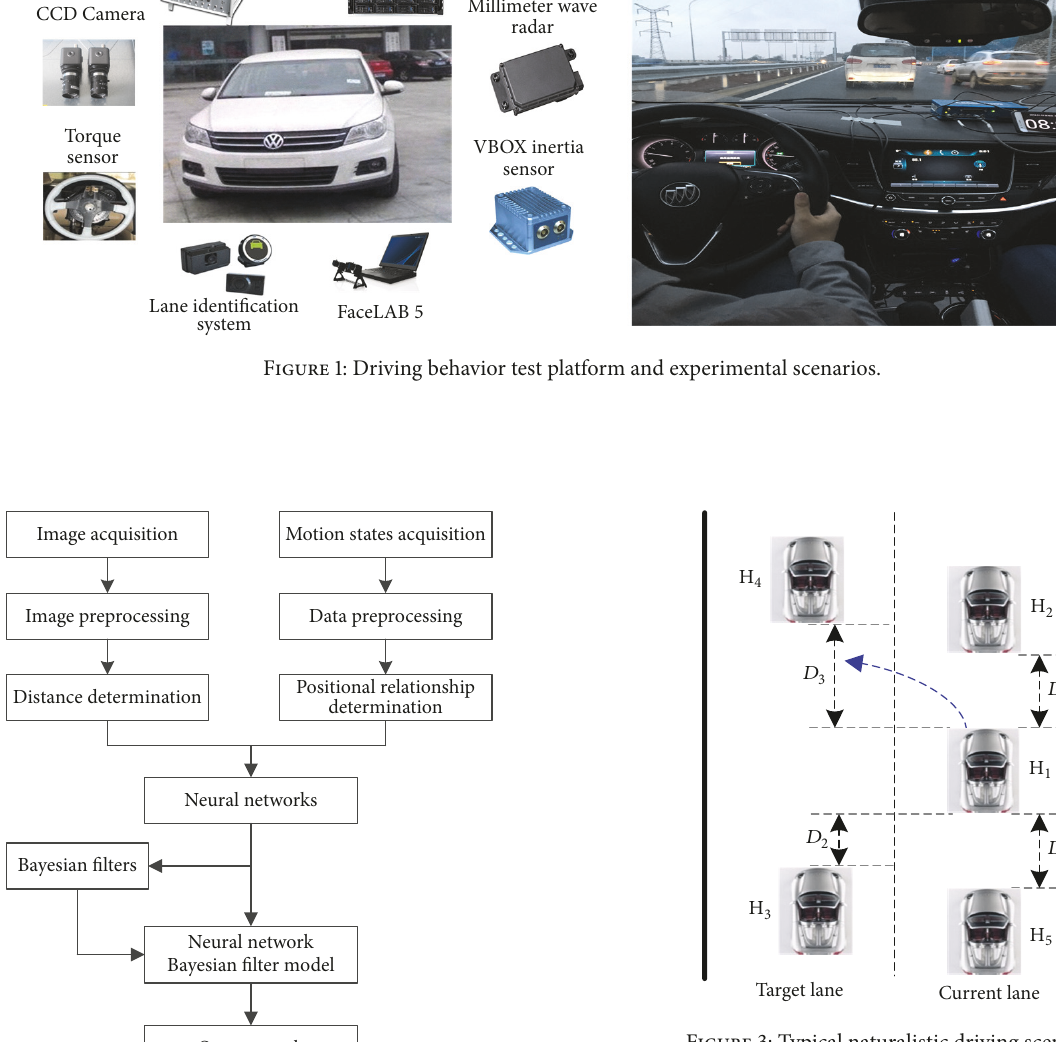
Figure 3: Typical naturalistic driving scenario.